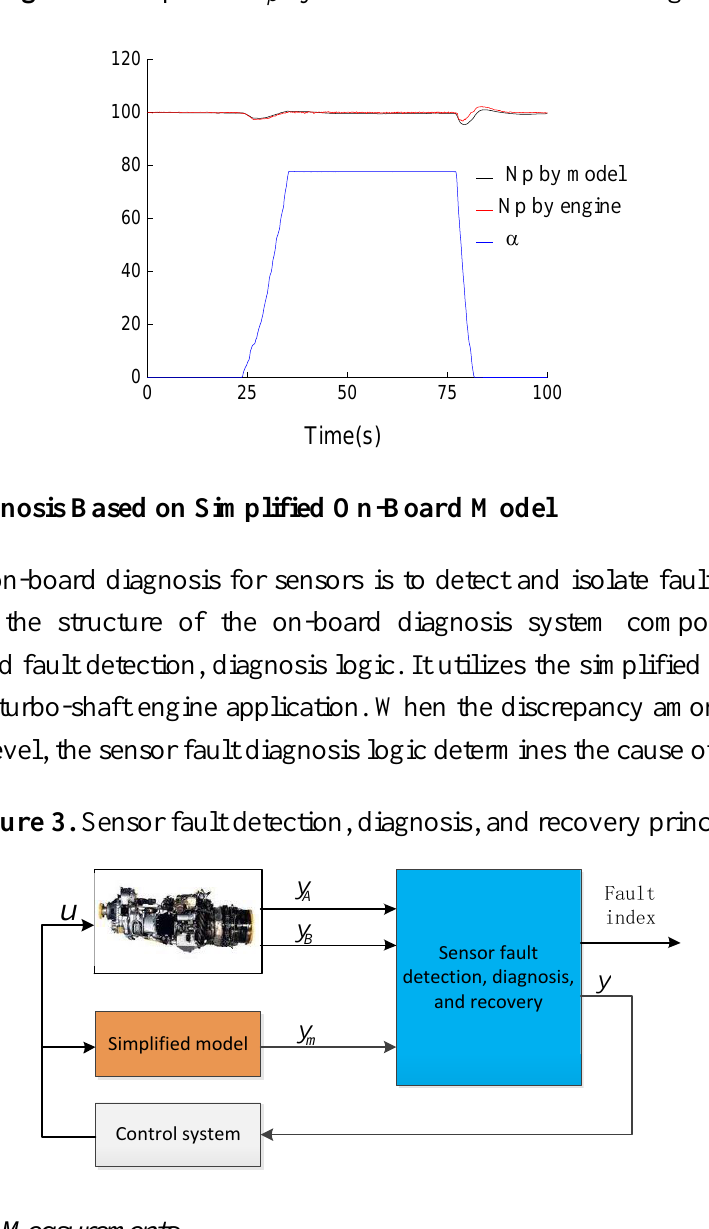
Figure 2. Outputs of n